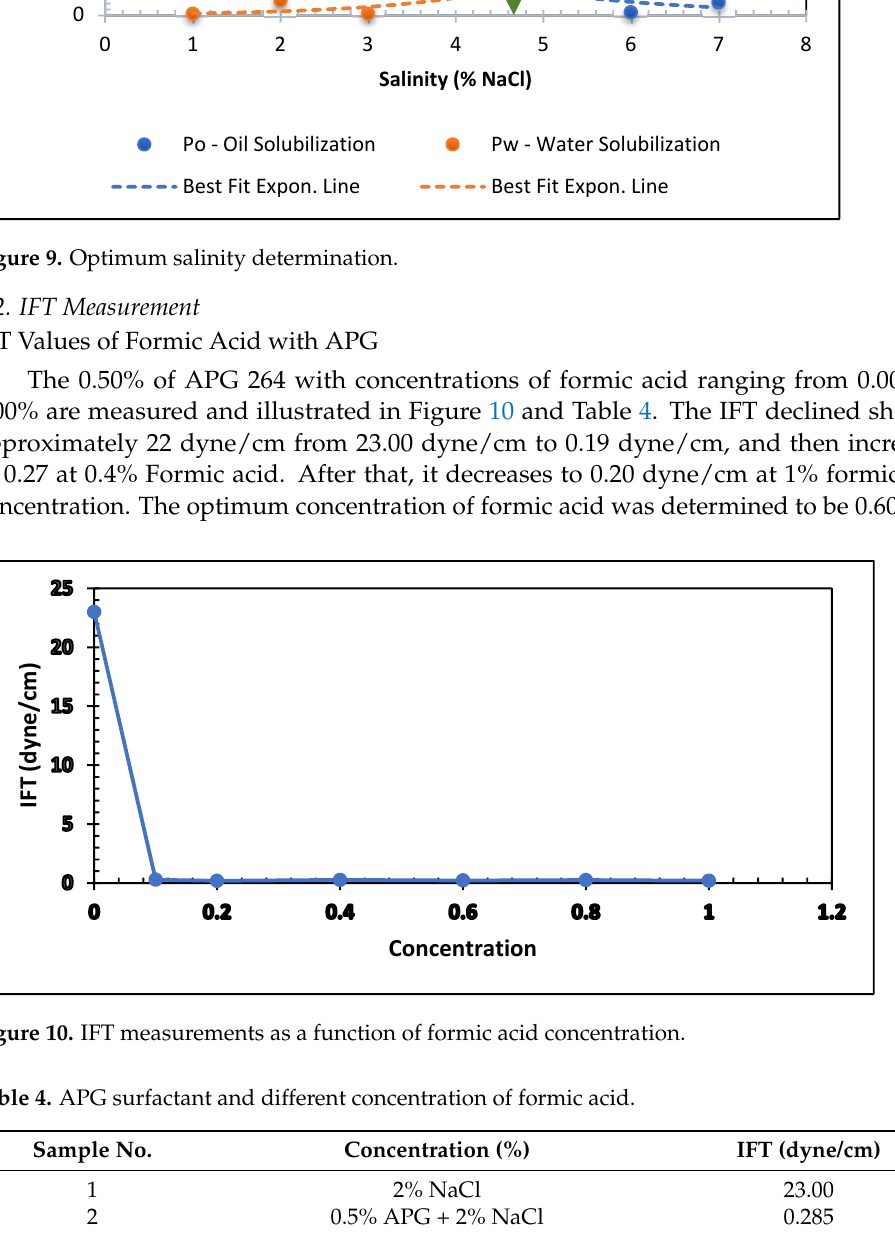
Figure 9. Optimum salinity determination.